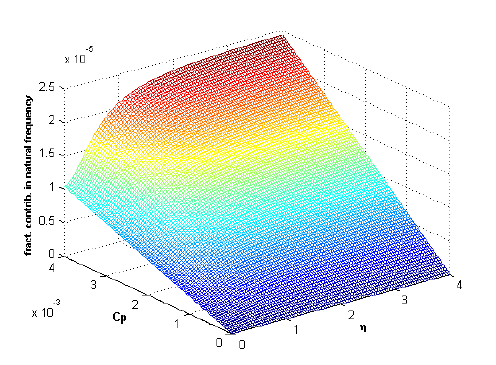
Figure 16. Fractional contribution frequency versus fractional damping coefficient Cp and nonlocality η ( α = 0.5).